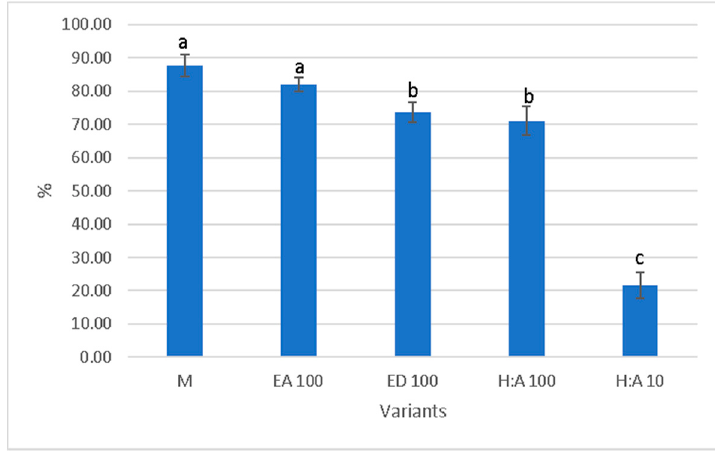
Figure 1. The influence of extracts on spore germination in Dryopteris affinis